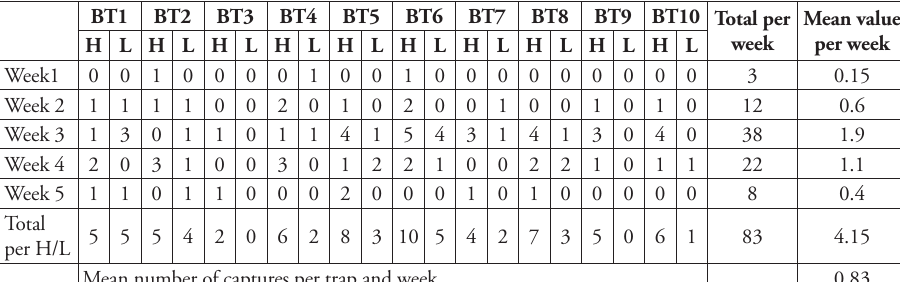
Table 8. An example of calculation of the total and mean value of the individuals counted. The mean value obtained is the reference number to compare the long-term data and to identify a population trend. The range of values obtained during the MIPP project varied between 29 captures with 8 baited traps (Bosco Fontana 2014) and 256 captures with 54 baited traps (Bosco Fontana 2016). (BT = baited trap, H= high, L=low) BT1 BT2 BT3 BT4 BT5 BT6 BT7 BT8 BT9 BT10 Total per Week1